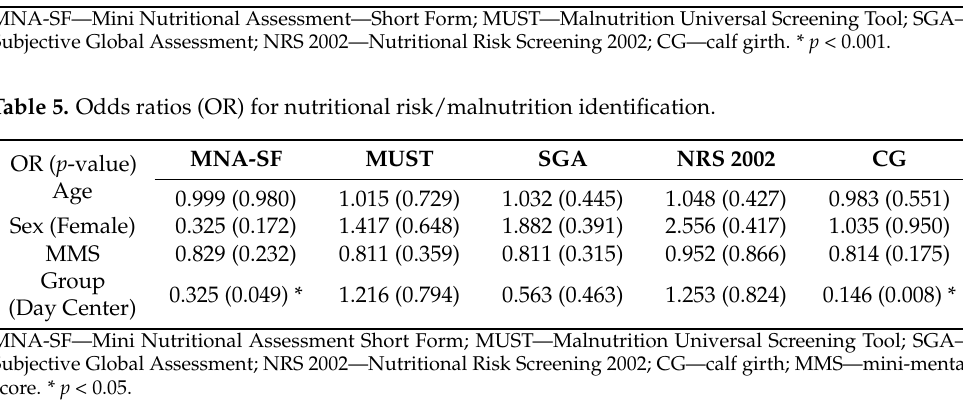
MNA-SF—Mini Nutritional Assessment Short Form; MUST—Malnutrition Universal Screening Tool; SGA— Subjective Global Assessment; NRS 2002—Nutritional Risk Screening 2002; CG—calf girth; MMS—mini-mental score. * p <